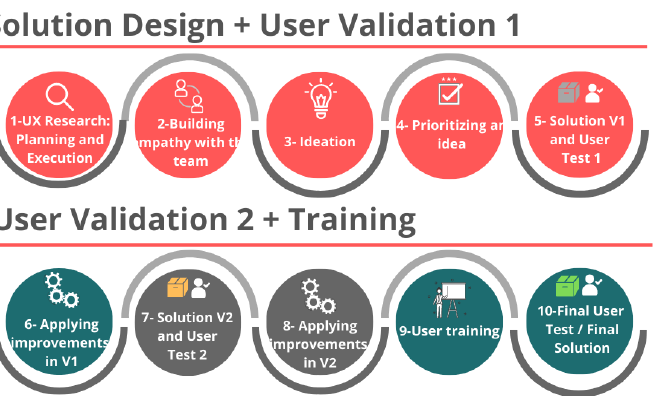
Figure 5. Flow of the conceptual model of empathy analysis, inspired by renowned methodologies [elaborated by the authors].